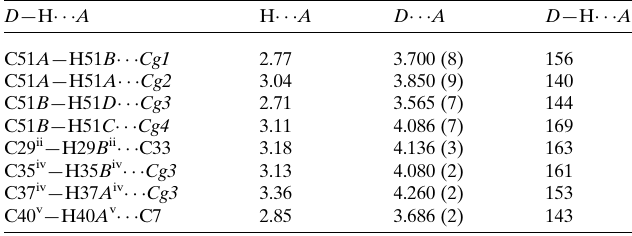
Table 2 Summary of weak interactions (A˚ , (cid:5) ). Cg 1– Cg 4 are the centroids of the C15–C17/C15 i –C17 i , C1–C6, C8–C13 and C1 i –C6 i rings, respectively.